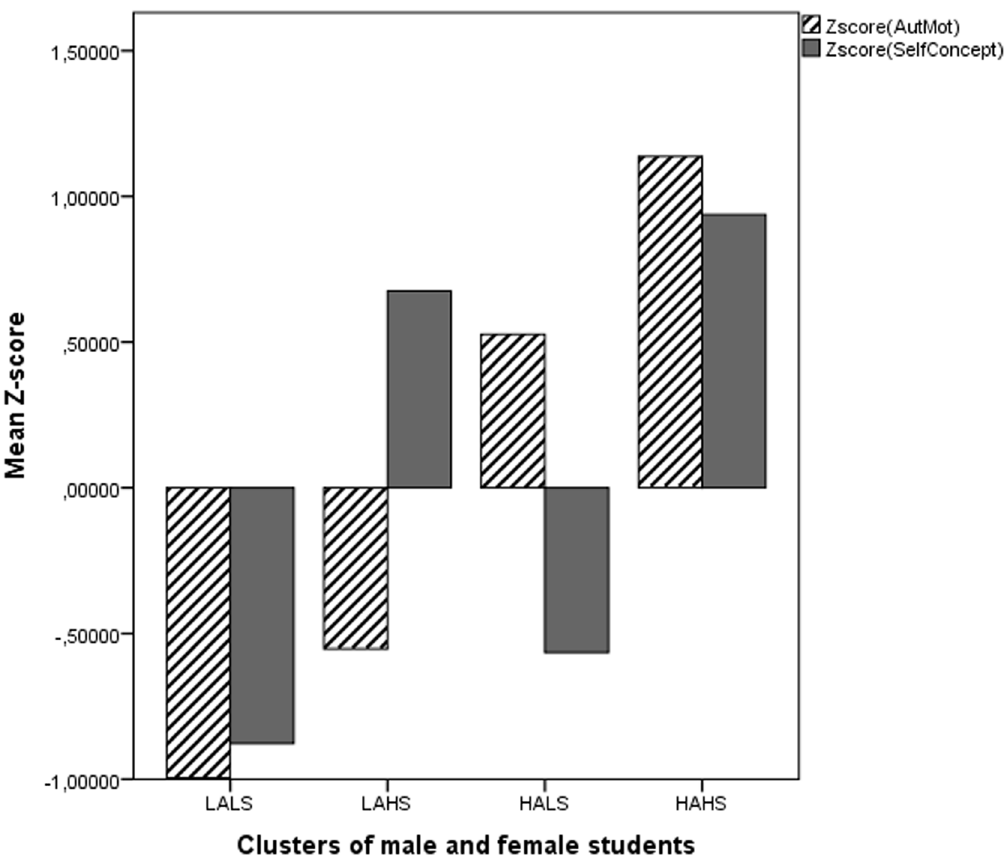
Figure 1. Autonomous motivation and academic self-concept of four-cluster solution of entire group of STEM students. Average z- scores for autonomous motivation (striped bar) and academic self-concept (gray bar) of the four-cluster solution of both male and female STEM students together.